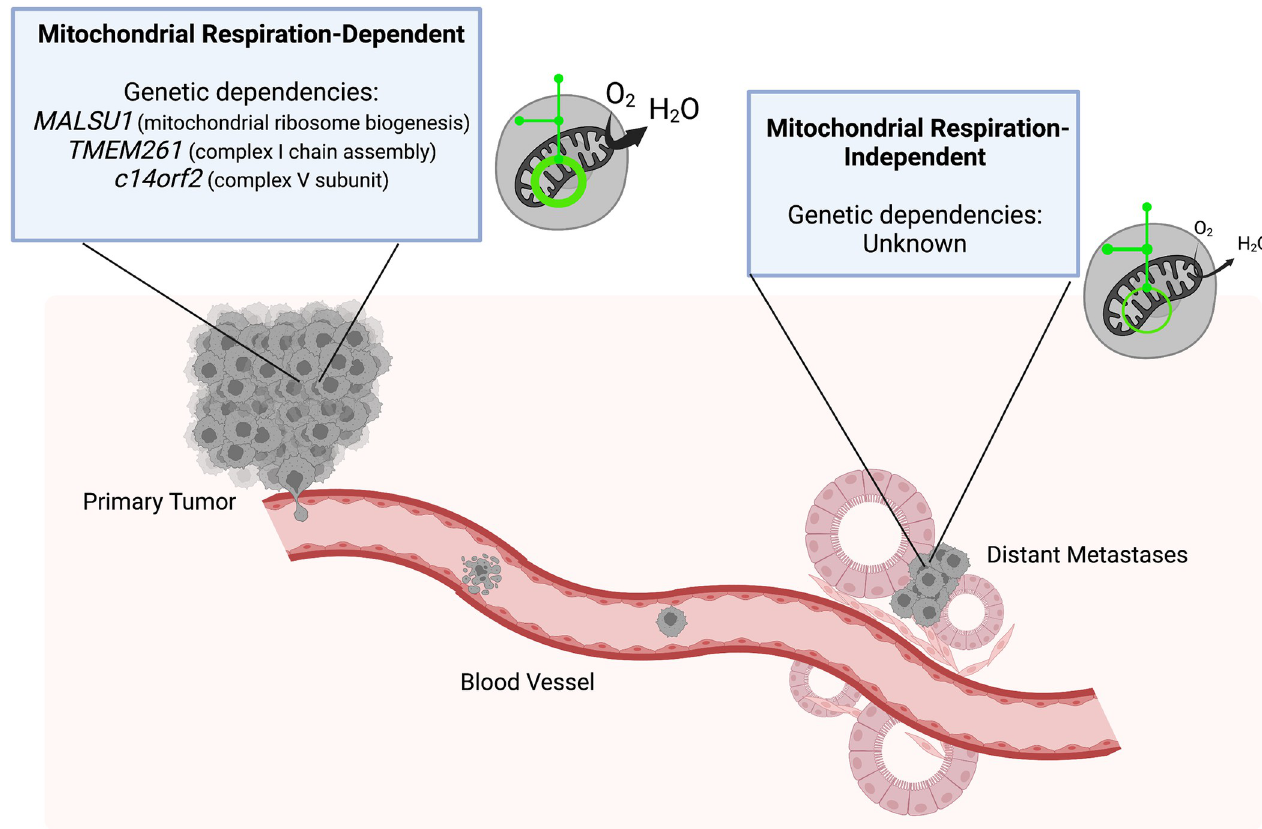
Fig 1. Primary tumor growth and metastasis possess unique metabolic dependencies. Cancer cells growing at the primary tumor site are dependent on genes involved in mitochondrial protein translation and respiration ( MALSU1 , TMEM261 , c14orf2 ) (left). In contrast, there is surprisingly low dependence on these genes for the formation of distant metastases (right). Figure created using